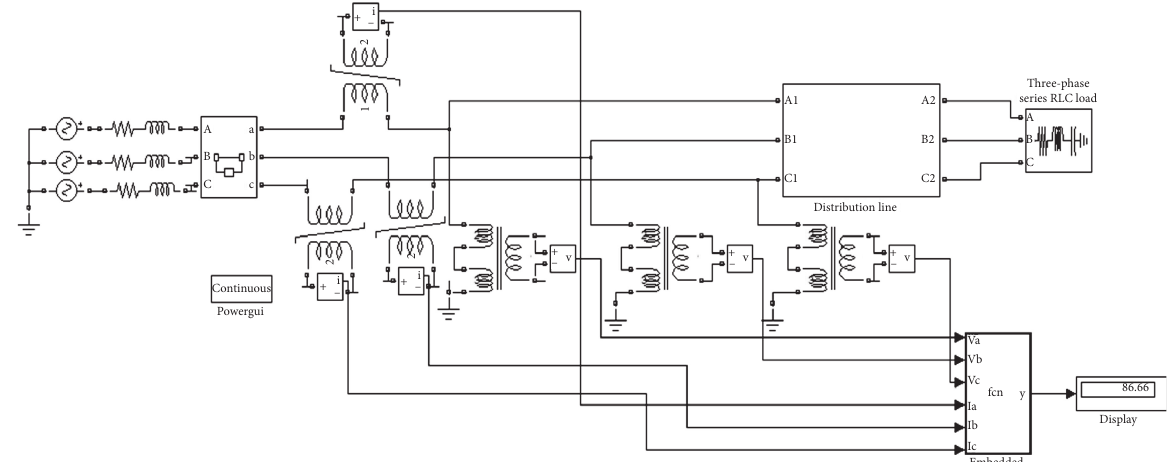
Figure 2: Simulink model for the impedance-based method.